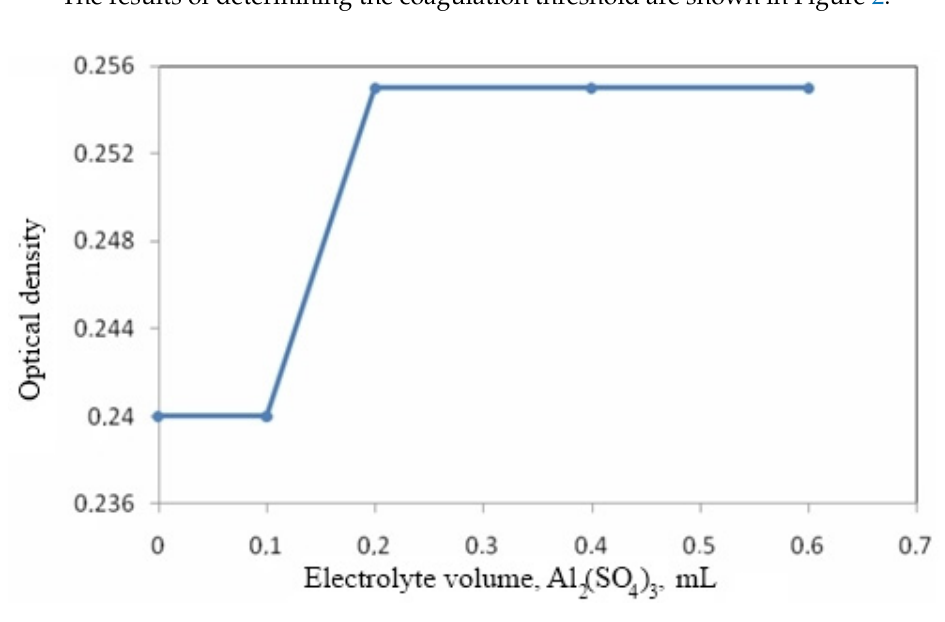
Figure 2. Dependence of optical density on the volume of electrolyte ‐ coagulator.